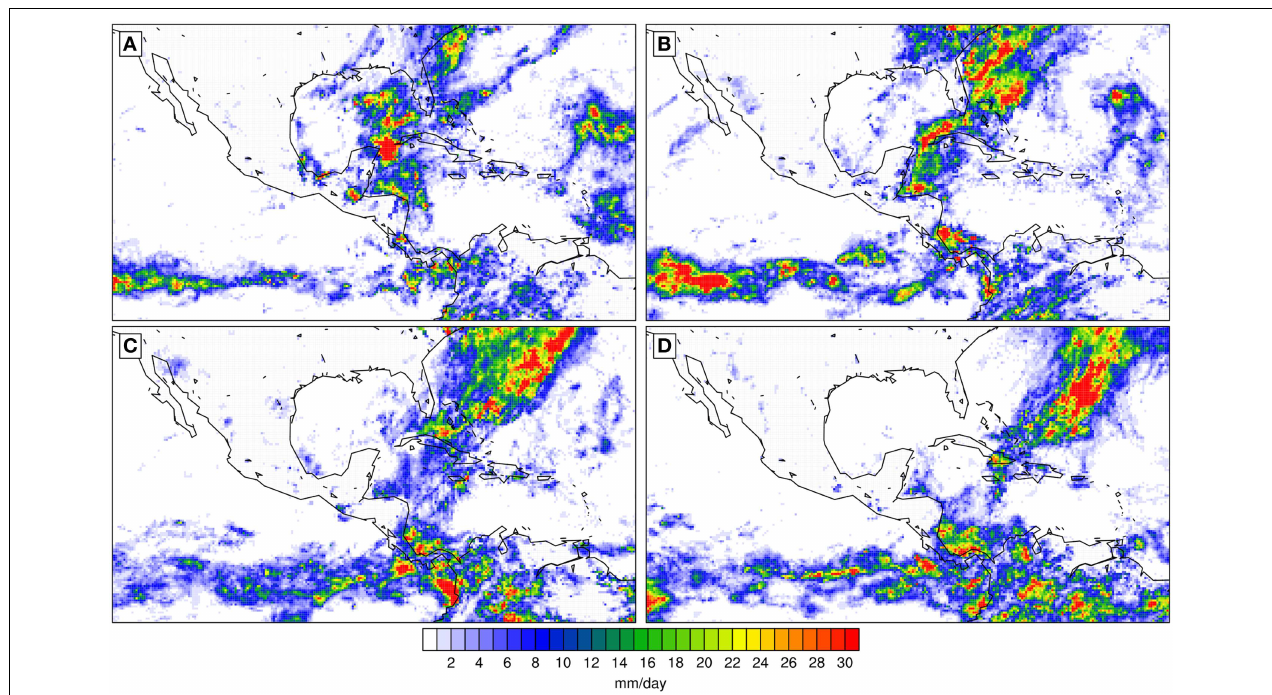
FIGURE 14 | Composited TRMM 3B42 precipitation estimates [mm/day] for the time evolution of a canonical 3-days WNWS event. (A) shows fields typical for the day previous to the onset. (B–D) show fields typical of days 1, 2 and 3